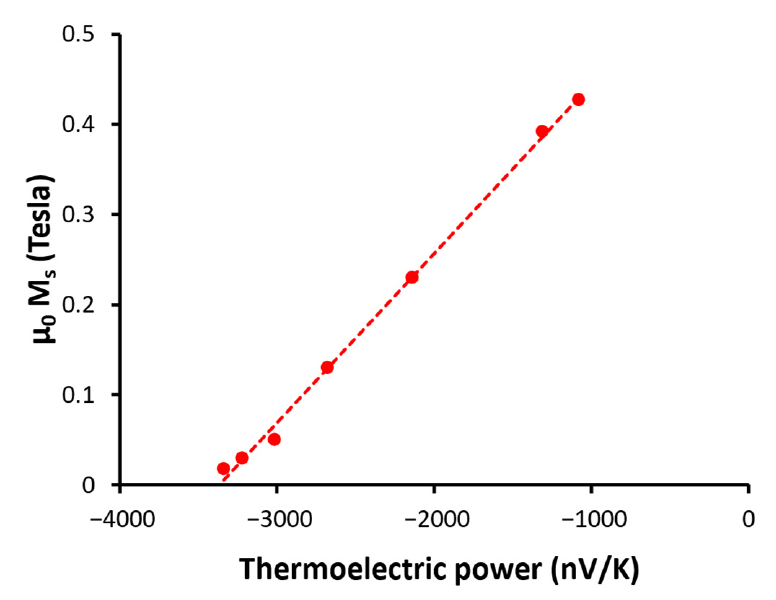
Figure 6. Magnetic saturation polarization vs. thermoelectric power of the cold-rolled and heat- treated samples.